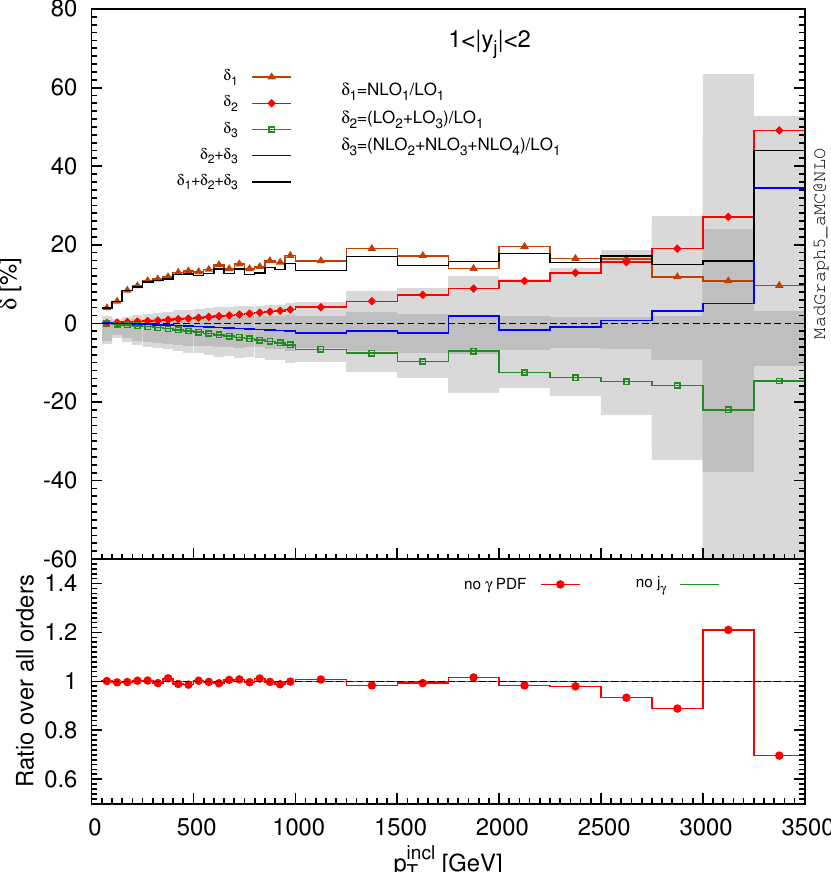
Figure 7 . Single-inclusive transverse momentum, for 1 < j y j (cid:20)